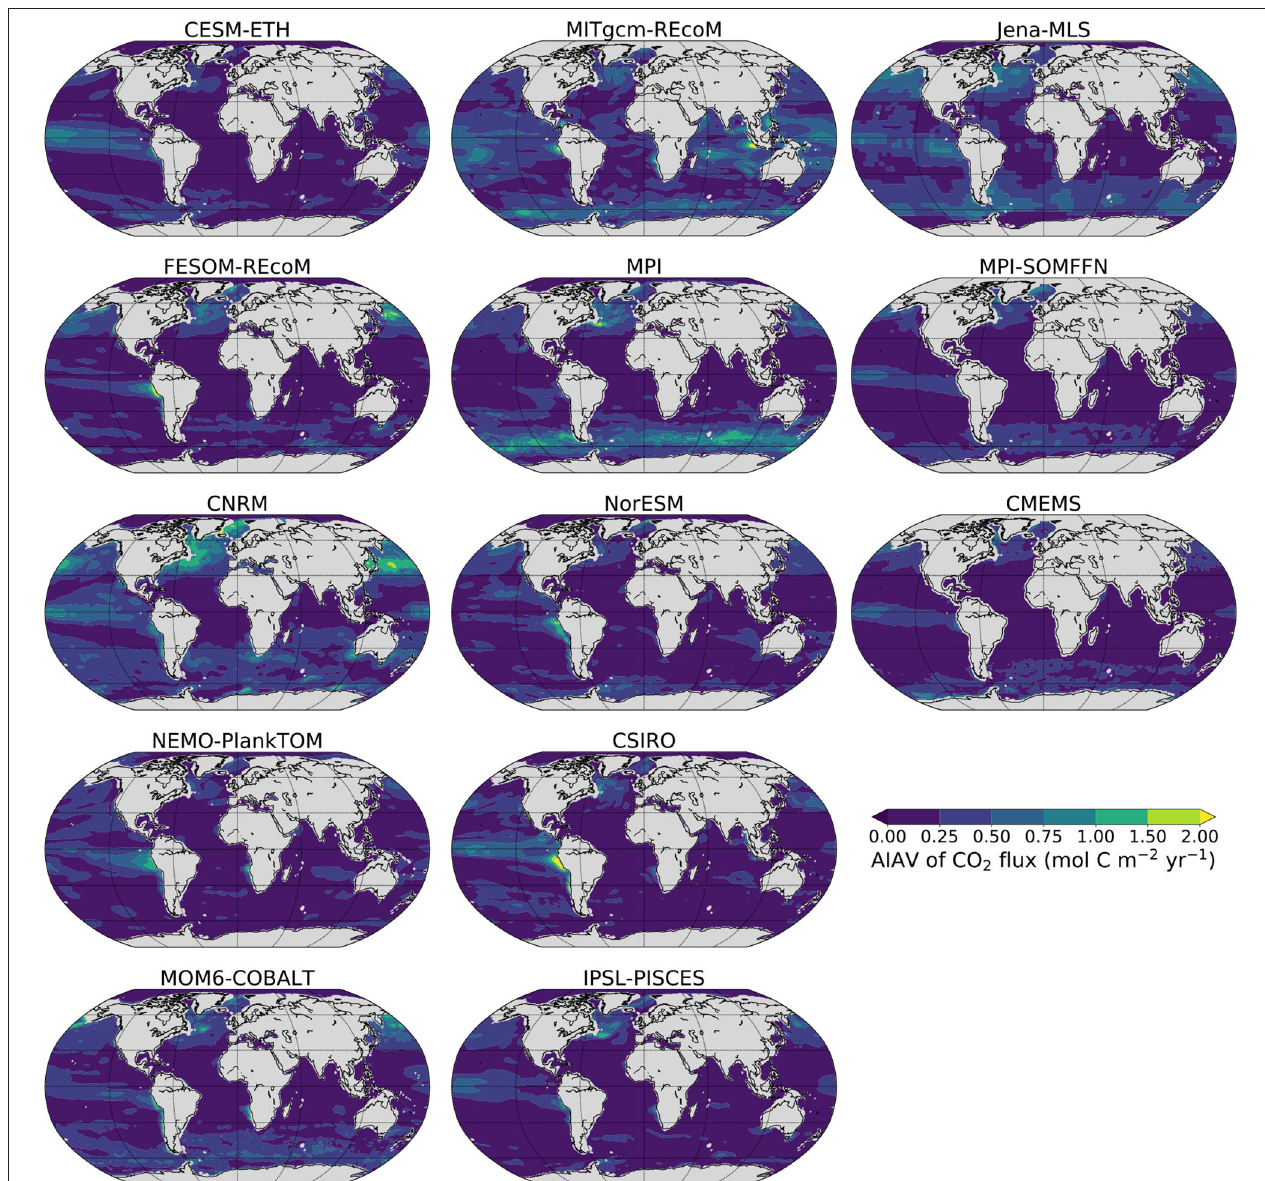
FIGURE 6 | Spatially resolved amplitude of interannual variability (AIAV) of annual air-sea CO 2 flux calculated as the standard deviation of the detrended annual CO 2 flux for all GOBMs and data-products.